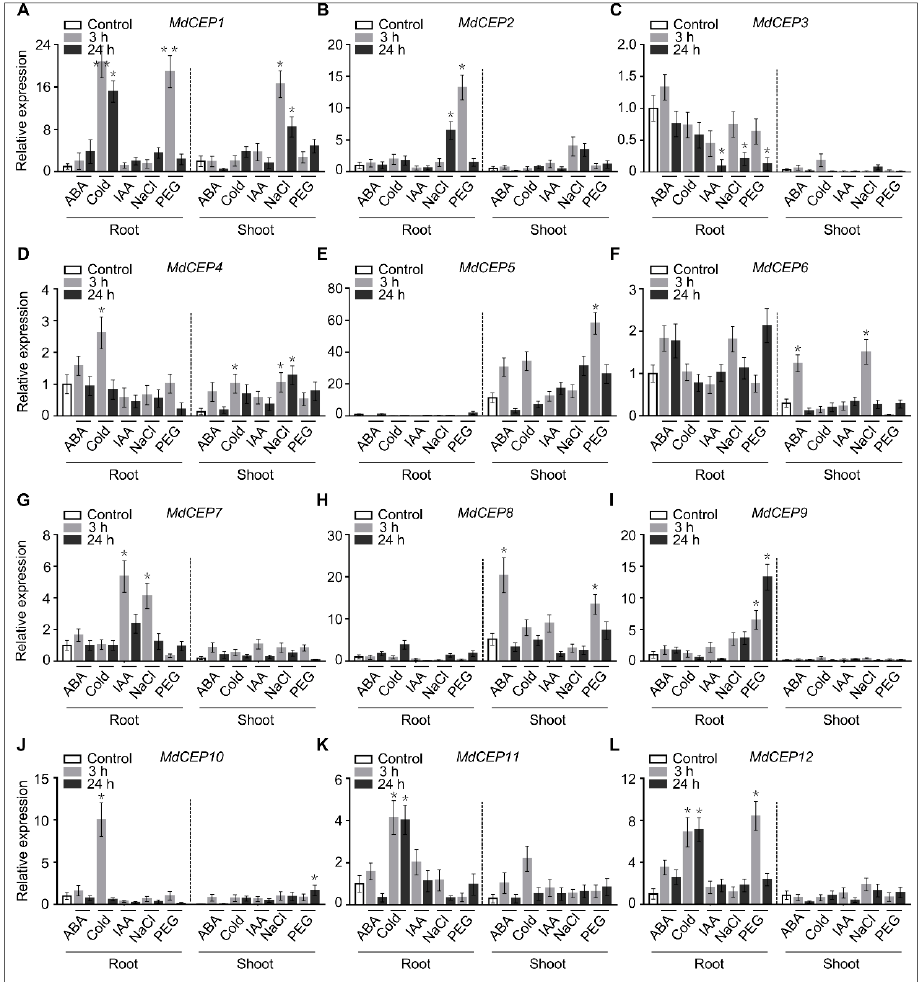
Figure 4. The expression pattern of MdCEPs under stress treatments in apple. Fourteen-day-old seedlings of Malus hupehesis (Pamp.) Rehd supplied with different treatments and the aboveground parts and roots are collected for RNA extraction and qRT-PCR analysis. ( A–L ) Representation of the transcription levels of MdCEP1 – MdCEP12 . Relative abundance of MdCEP1 – MdCEP12 transcripts from various treatments represented as fold change relative to mock-treated values and normalized against 18s rRNA . Error bars indicate SEM ( n = 3). * p < 0.05; ** p < 0.01 (Student’s t -test). These experiments were repeated three times with similar results.